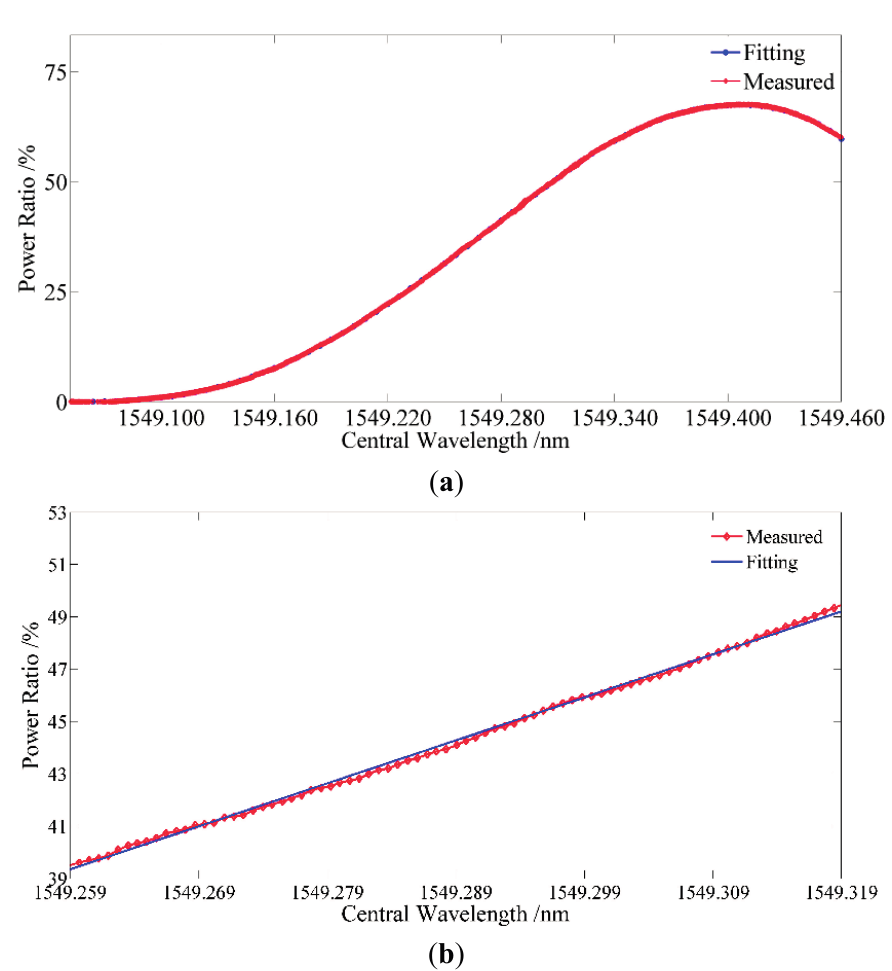
Figure 11. Schematic diagram of seFBG axial displacement signal generator.